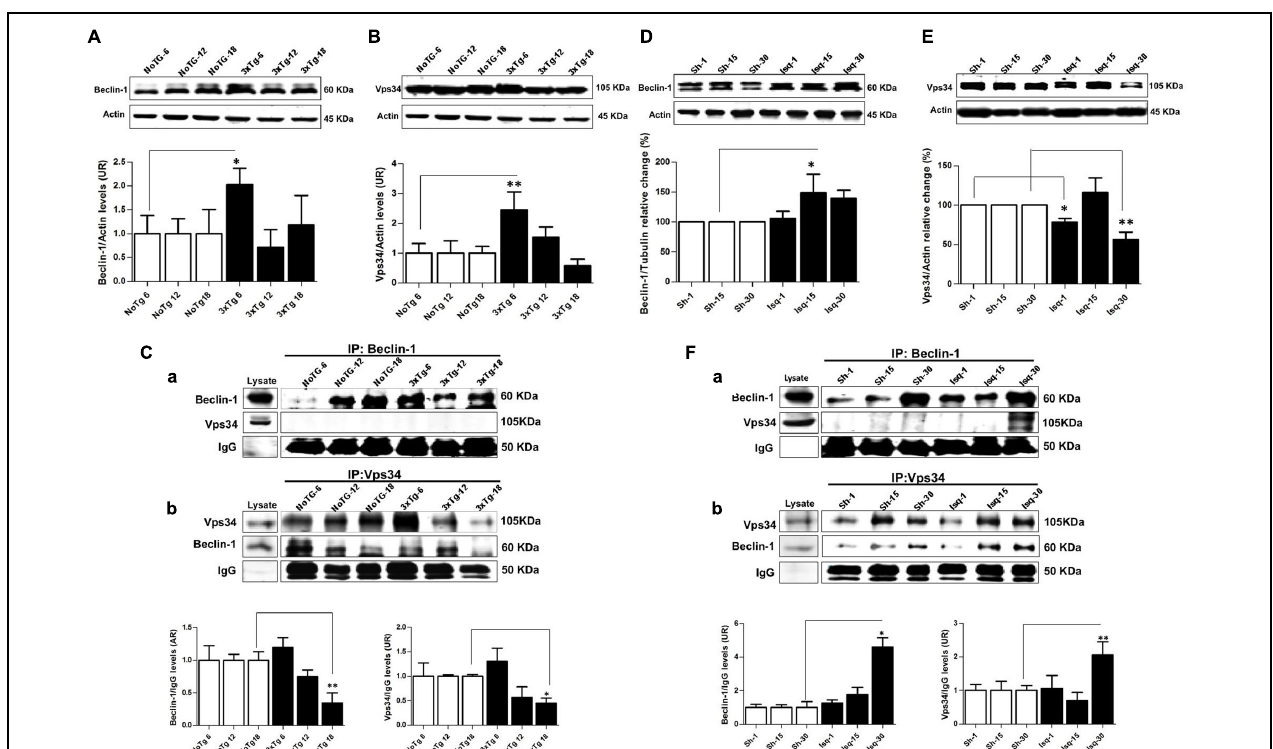
FIGURE 3 | Macroautophagy effects on the cerebral cortex of 3xTgAD mice compared with cerebral ischemia in rats. Representative bands from SS-Cx lysates of 3xTgAD and ischemic rats were evaluated by Western blotting and immunoprecipitation. (A) Beclin-1 ( p ≤ 0.043) and (B) Vps34 ( p ≤ 0.029) increased in 3xTg-AD at 6 months. (C) The Vps34/Beclin-1 association was lost at 12 and 18 months. (D,E) Beclin-1 increased at 15 days in Ischemic rats ( p ≤ 0.029) and Vps34 was reduced at 1 day ( p ≤ 0.021) and 30 days